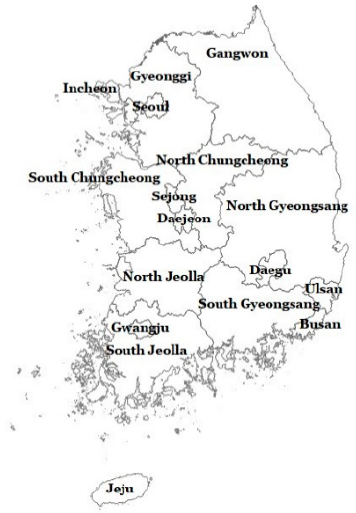
Figure 1. Map of administrative divisions at the provincial level in South Korea (Source: Statistical Geographic Information Service of the Statistics Korea: SGIS).